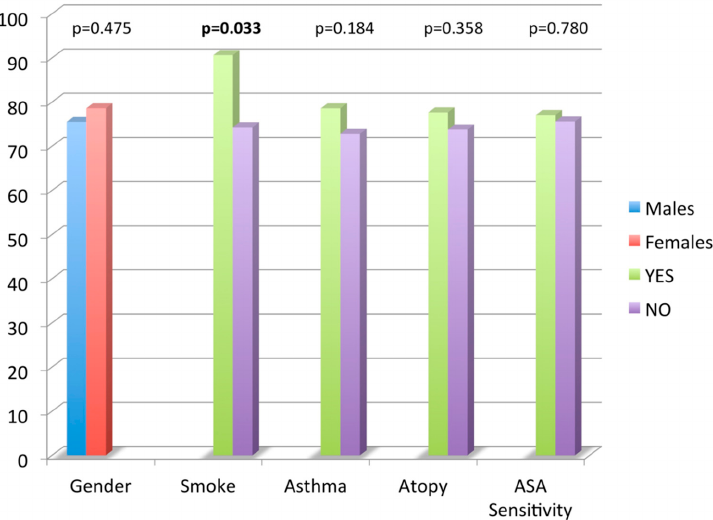
Figure 1. Nasal Polyposis Quality of Life (NPQ) questionnaire total score mean values according to age, smoking habits, asthma, atopy and acetyl salicylic acid (ASA) sensitivity.